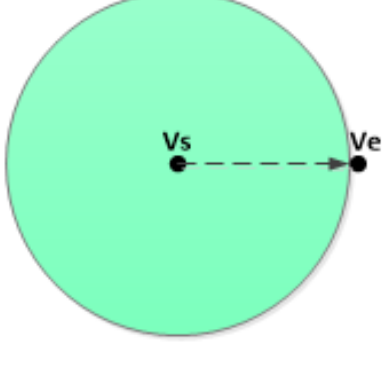
Figure 1. Search space of the Dijkstra